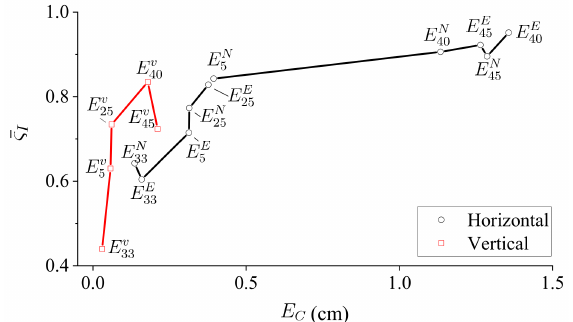
Figure 8. Relationship between E C and ς I